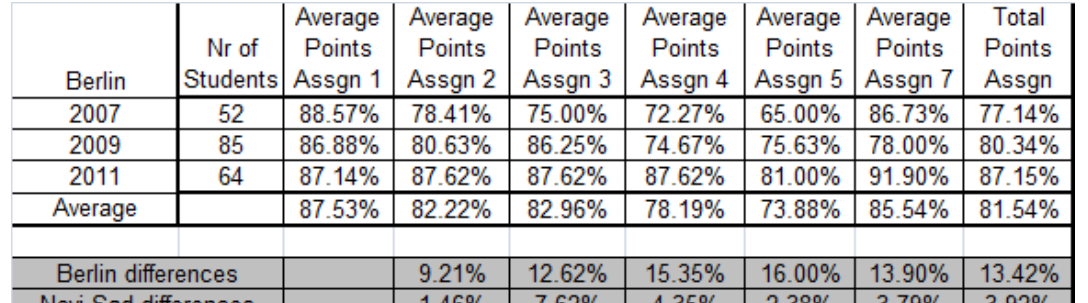
Assignment Points for Berlin